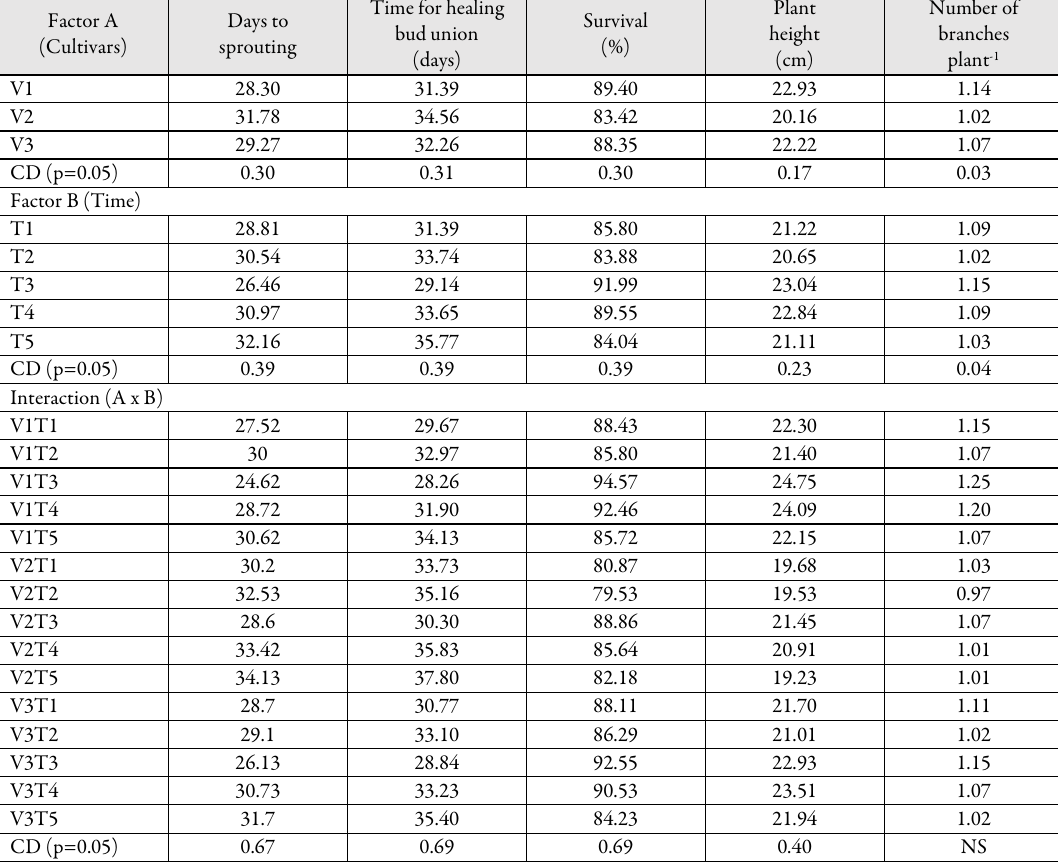
Table 1. Effect of sweet orange cultivars and time of budding on sprouting and buddling vigour Factor A